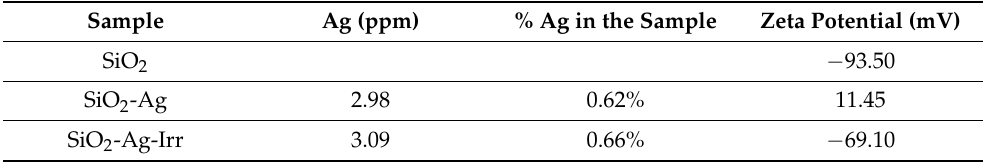
Table 1. Silver content on the samples and Zeta-potential values.